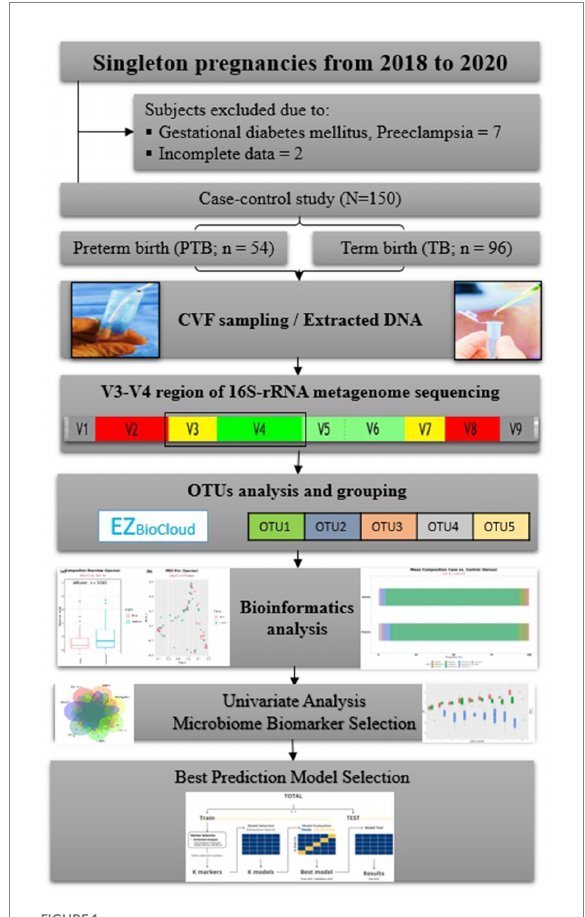
FIGURE 1 Flowchart of the study. CVF, cervicovaginal fluid; rRNA, ribosomal ribonucleic acid; OTUs, operational taxonomic